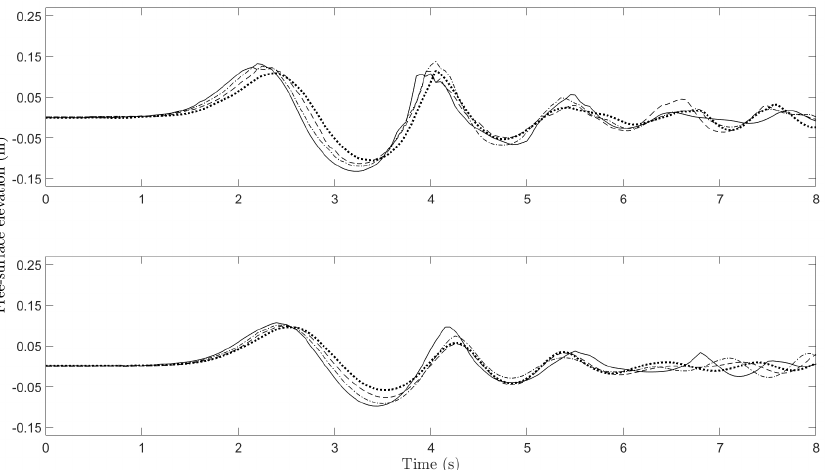
Figure 12. Records of free-surface elevation at x = 7 m. ( Top ) Results for Case 00 (solid line); Case 01 (dash-dotted line); Case 02 (dashed line); and Case 03 (dotted line). ( Bottom ) Results for Case 04 (solid line); Case 05 (dash-dotted line); Case 06 (dashed line); and Case 07 (dotted